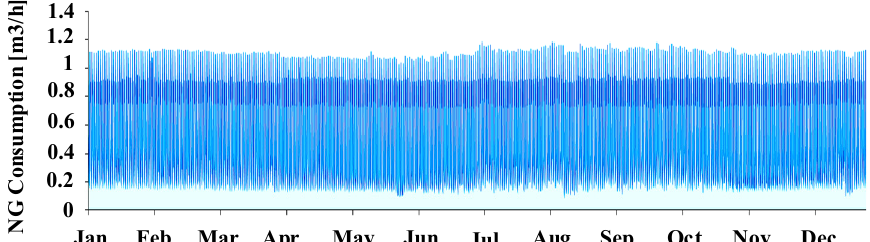
Figure 19. Daily NG consumption of the boiler and FC.